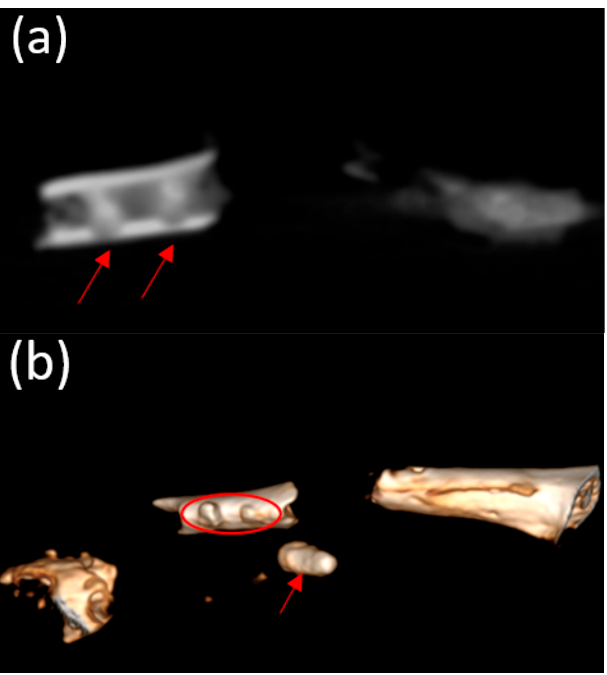
Figure 8. ( a ) Projection of the fragments of the femur of an animal after 1 month. ( b ) CBCT 3D- reconstructed data after implantation.